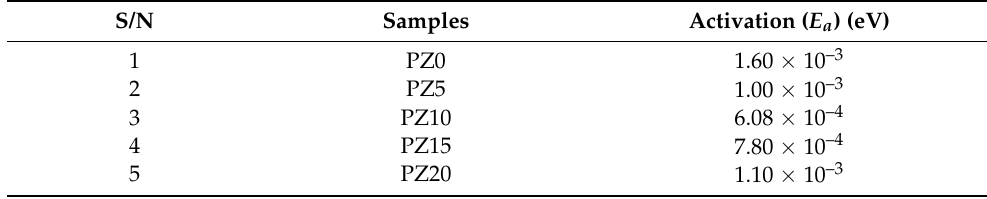
Table 4. Activation energy ( E a ) of the prepared SPEs based on PVA–CA–K 2 CO 3 /ZnO-NPs.